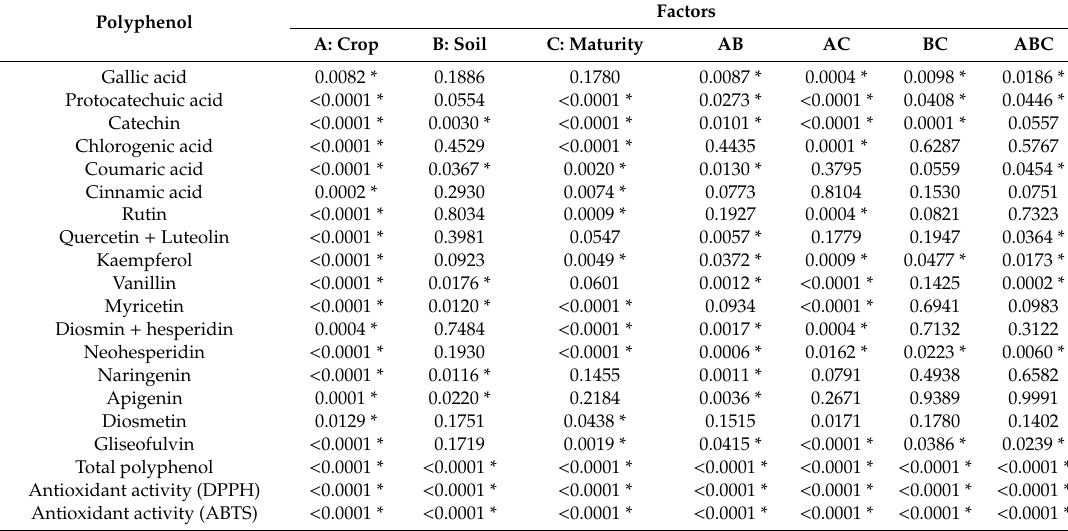
Figure 1. Results of the determination of antioxidant activity by DPPH ( A ), ABTS ( B ) and quantification of total polyphenols ( C ) in habanero pepper ( Capsicum chinense Jacq.) cultivated in three soils and with two degrees of maturity. Di ff erent letters indicate statistically significant di ff erences using least significant di ff erence (LSD) test at p ≤ 0.05. The error bars on the figure represent standard deviation. Table 3. p values of the di ff erent factors evaluated and their respective interactions for each of the quantified polyphenols, total polyphenols, and antioxidant activity (DPPH and ABTS).